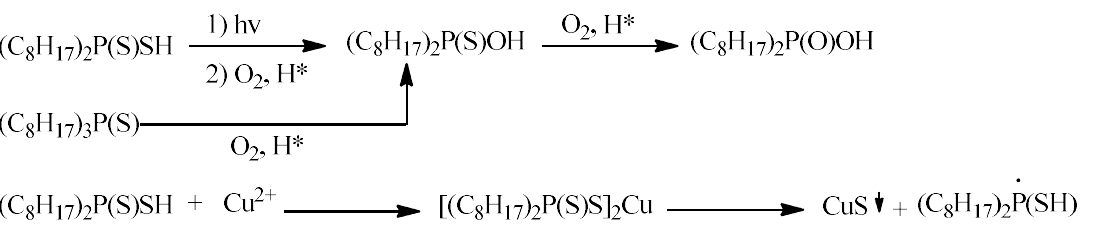
Figure 4. Hypothetical mechanism of the photodegradation of extractant Cyanex 301 [61].